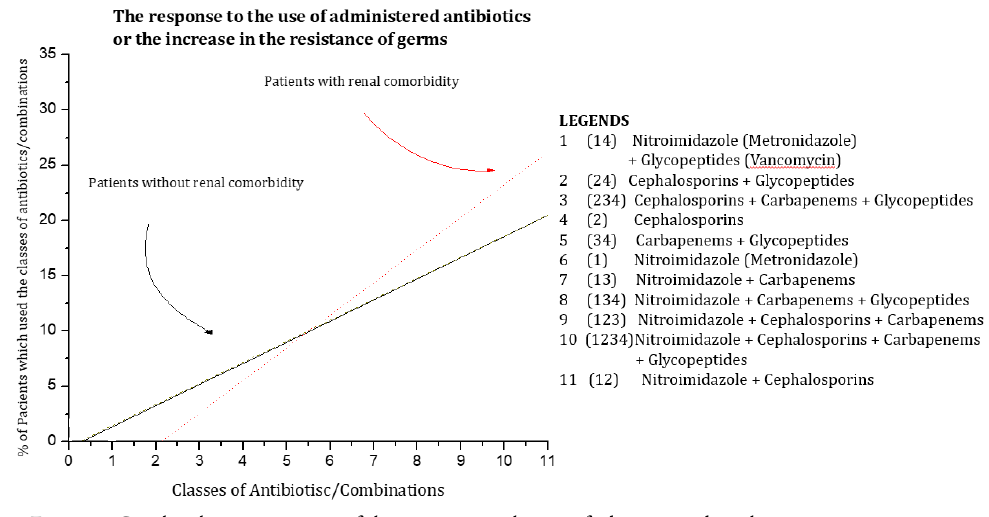
FigureFigureFigureFigure 5555. Graphical representation of the response to the use of administered antibiotics Analyzing the uremia values in the different groups of patients who received treatment with the combinations of antibiotics, it was found that patients without kidney damage did not require complex combinations of antibiotics as treatment, with a good response, but patients who were administered cephalosporins + carbapenems + glycopeptides (group 3) both those with kidney disease and those without kidney disease had high urea values and in the case of deceased patients urea had increased values both in the presence of kidney disease and in its absence, the treatment proving ineffective. In group 4, where only cephalosporins were administered, we obtained high urea values both in the group of patients with kidney diseases and in the case of those without kidney diseases, and in the case of deceased patients, the values of urea were greatly increased, proving the ineffectiveness of the antibiotic treatment. In group 11, where Nitroimidazole and Cephalosporins were administered, we obtained high values of uremia in all categories, including in the case of patients who died with kidney damage, proving that even in this case the antibiotic treatment was not effective. The most effective combinations proved to be the combinations Nitroimidazole- Glycopeptides (group 1), Cephalosporins-Glycopeptides (group 2), Carbapenems-Glycopeptides (group 5), Nitroimidazole (group 6) and the combination Nitroimidazole- Cephalosporins-Carbapenems-Glycopeptides (group 10), in these groups not being registered deaths (Figure